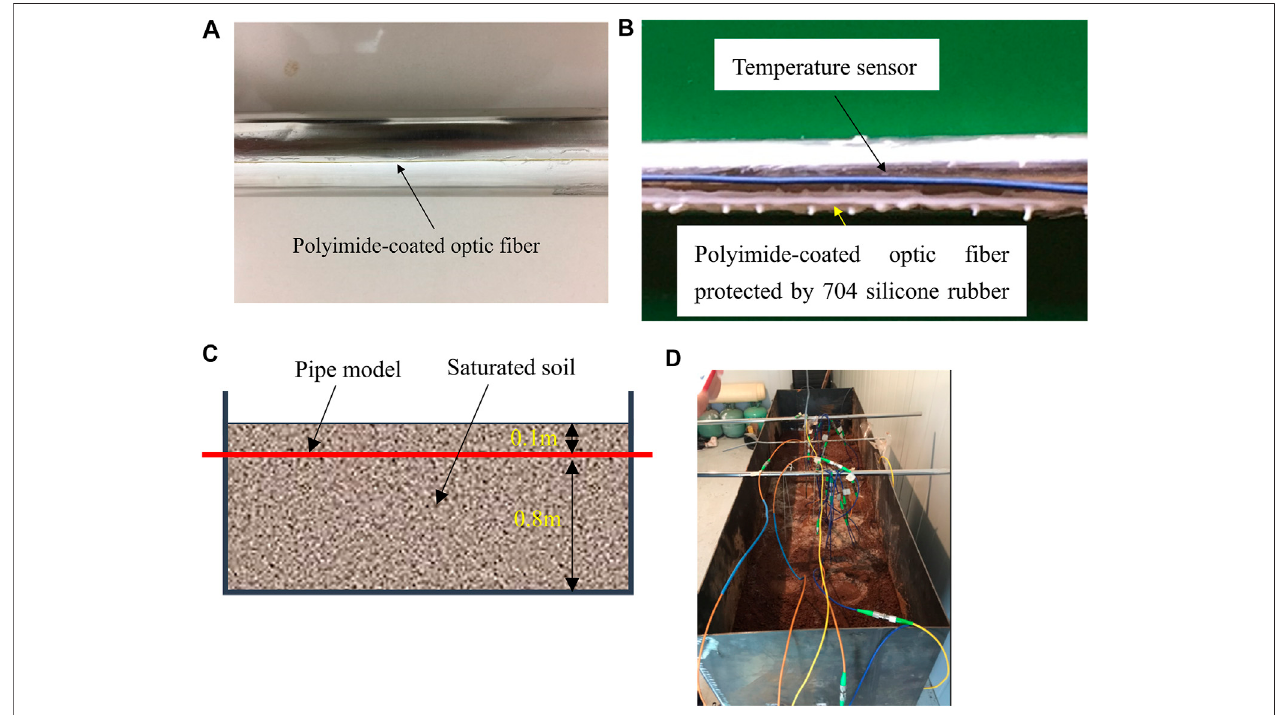
FIGURE7| Picturesofthetestillustration. (A) Polyimide-coated optic fi bersensor. (B) Pictureofthestrainsensorandtemperature sensor. (C) Position ofthepipe model. (D) Steel tank.